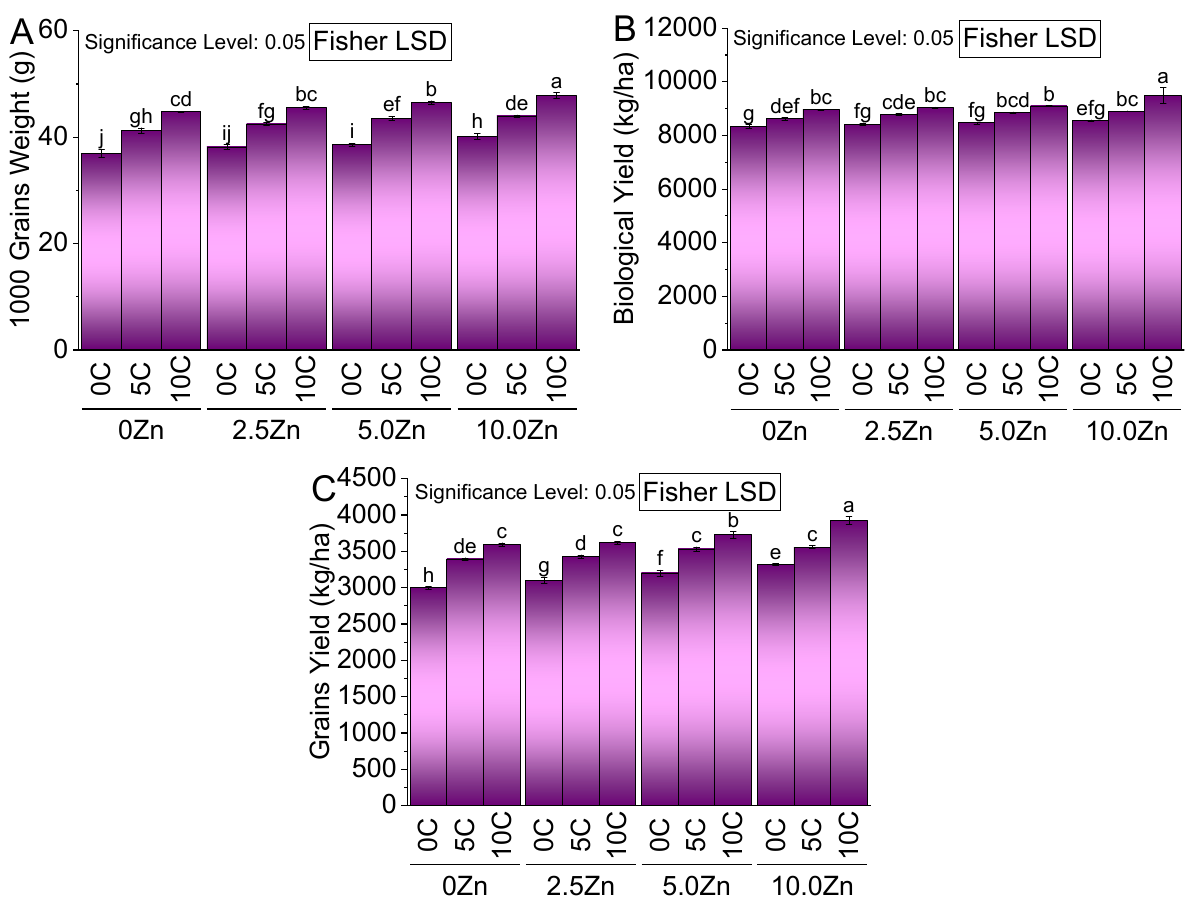
Figure 2. Impacts of various zinc application amounts (0, 2.5, 5.0 and 10.0 kg/ha) with different levels of compost (0, 5 and 10 t/ha) on 1000-grain weight ( A ), biological yield ( B ) and grain yield ( C ) of wheat. Different letters above bars represent significant changes at p ≤ 0.05 using Fisher’s LSD test.